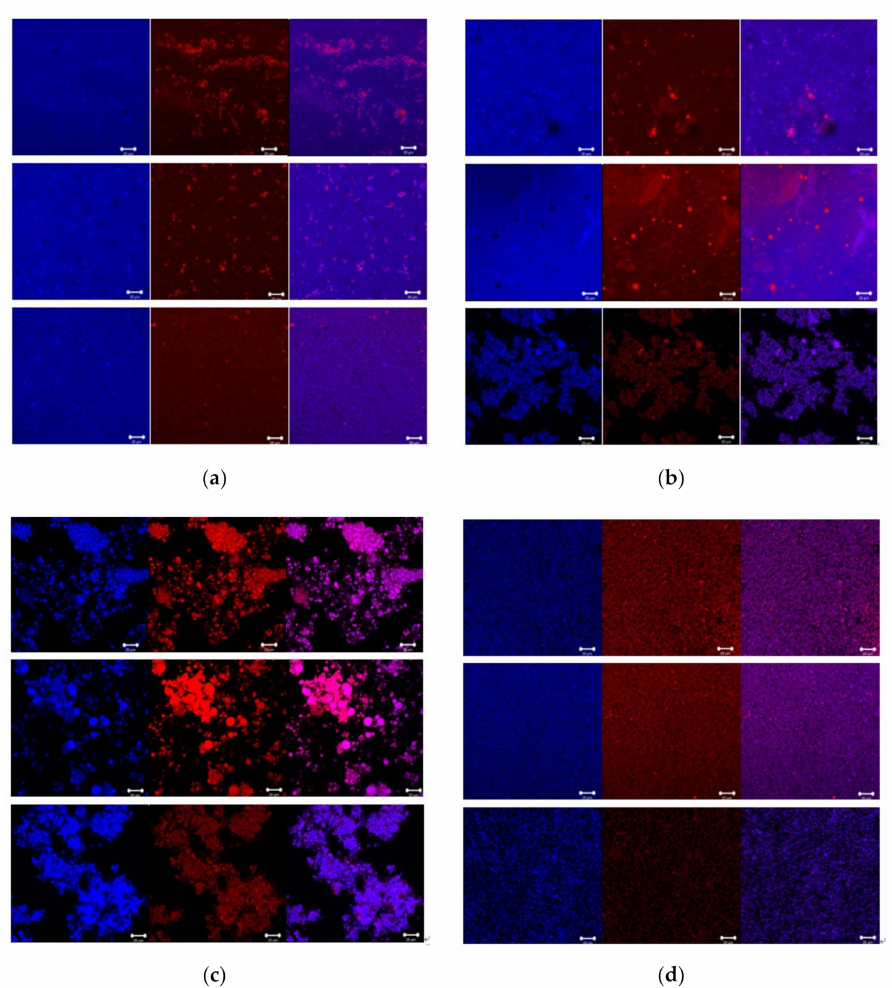
Figure 4. Confocal images of sample dispersions under different treatments. ( a ) NEY, NEP and NEG (natural egg yolk, natural egg plasma and natural egg granule, respectively). ( b ) HEY, HEP and HEG (heated egg yolk, heated egg plasma and heated egg granule, respectively). ( c ) LEY, LEP and LEG (egg yolk hydrolyzed by lipase, egg plasma hydrolyzed by lipase and egg granule hydrolyzed by lipase, respectively). ( d ) PEY, PEP and PEG (egg yolk hydrolyzed by phospholipase, egg plasma hydrolyzed by phospholipase and egg granule hydrolyzed by phospholipase, respectively). Scale bars in images mean 20 µ